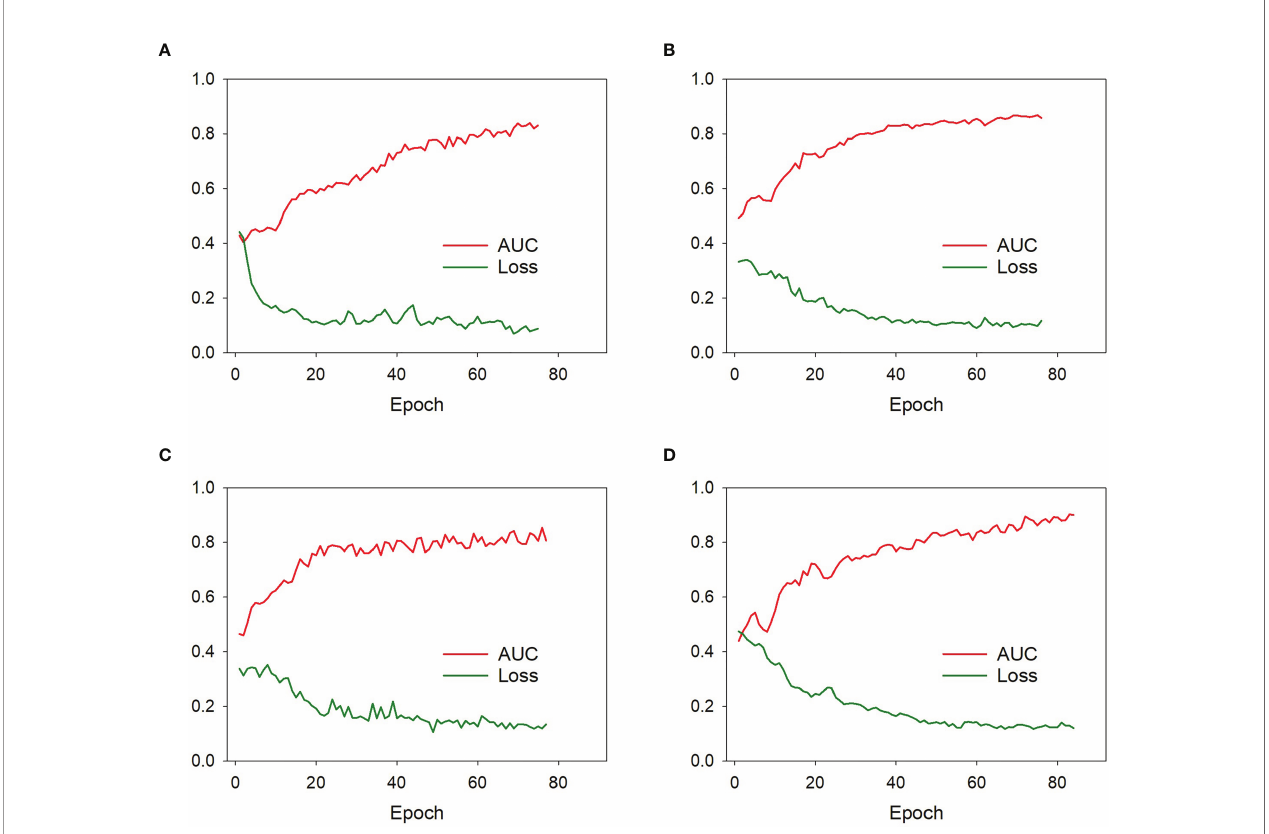
FIGURE 4 | The model ef fi ciency (AUC) and cross-entropy loss function corresponding to each epoch of the model 1 (A) , model 2 (B) , model 3 (C) , and model 4 (D) during training process. The model ef fi ciency corresponding to each epoch gradually increased while the model loss function decreased and eventually